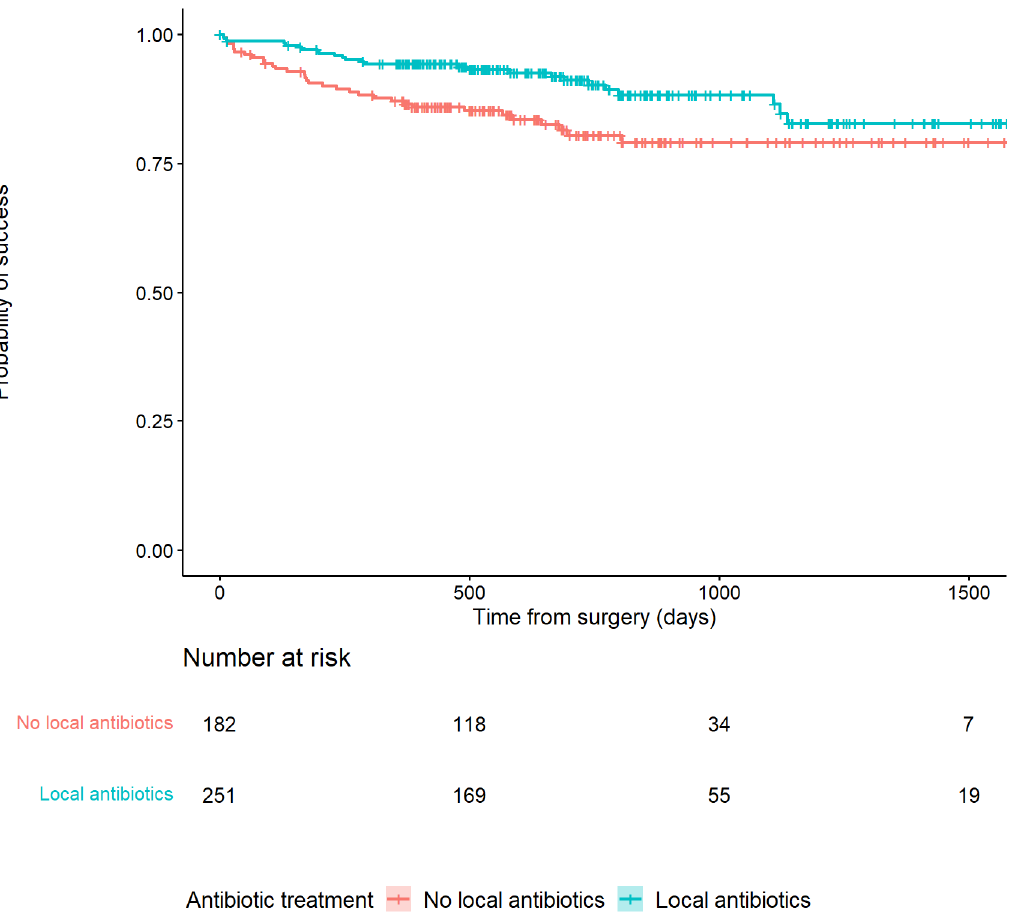
Figure 2. Kaplan–Meier Survivorship curve demonstrating the relationship between patients treated with or without antibiotic-loaded carriers and recurrence of infection.